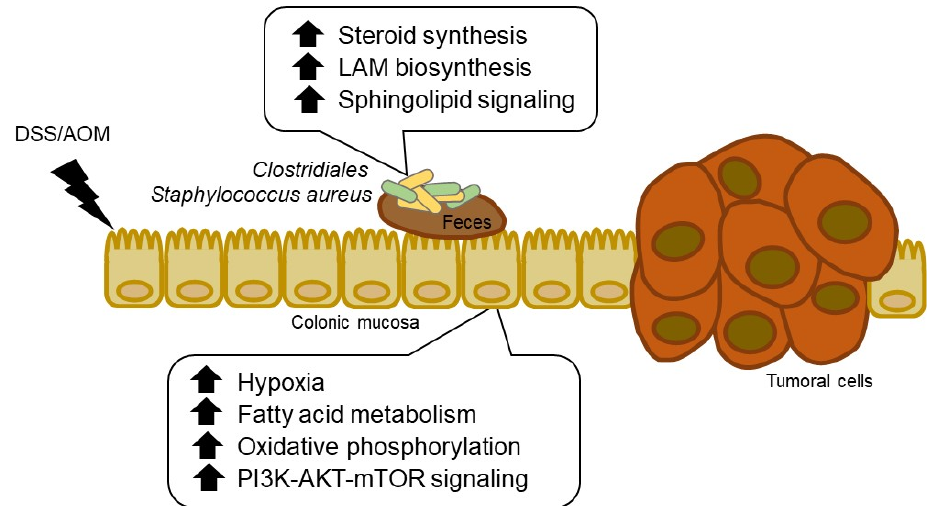
Figure 7. Schematic summary of host transcriptome and microbiome signaling-pathway on mouse DSS/AOM-induced colon cancer. DSS/AOM; dextran sodium sulfate + azoxymethane, LAM; lipoarabinomannan.